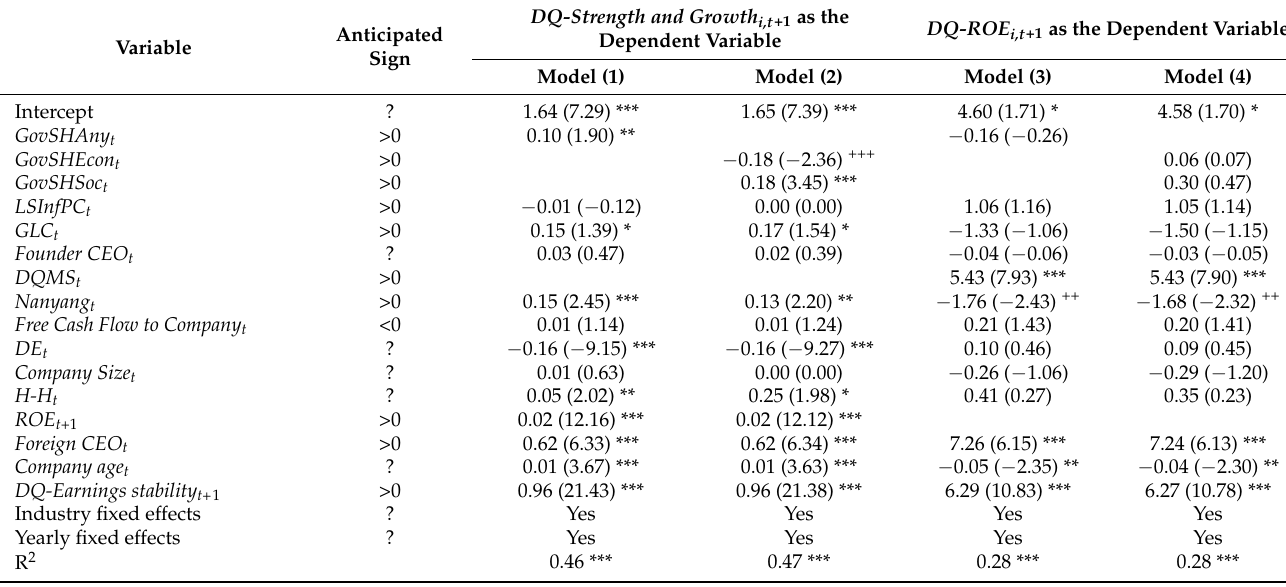
Table 4. OLS estimation of models testing H1—Using default classifications of types of government-related investors.